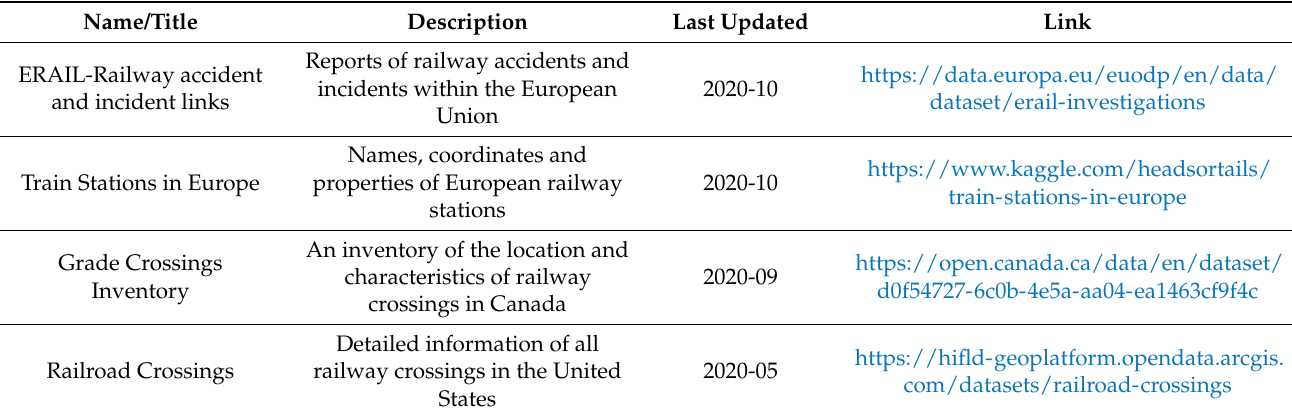
Table 4. Selected supporting datasets and public APIs. The links were accessed between 15 September 2020 and 15 January